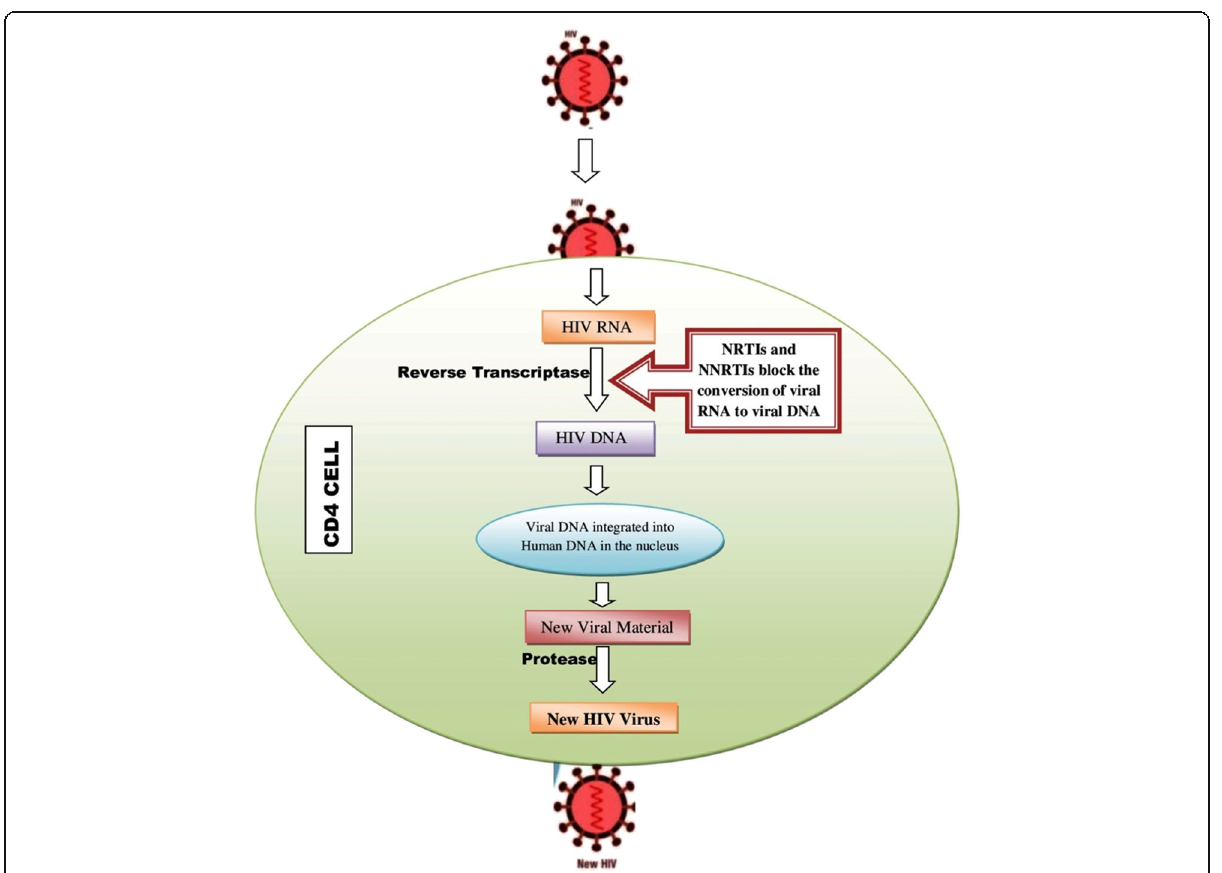
Fig. 1 Mechanism of reverse transcriptase inhibitors in